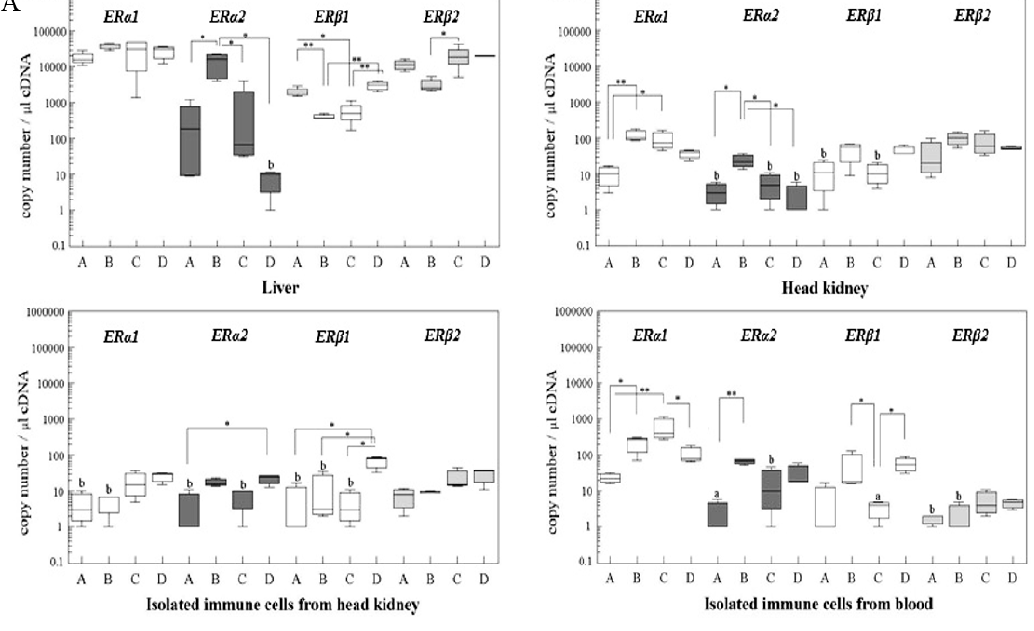
Figure 5. ( A ): The mRNA expression levels of the four ER isoforms in the liver, head kidney (HK), immune cells isolated from head kidney or from blood during the reproductive cycle. The reproductive cycle was subdivided into four stages: stage A = start of reproductive cycle, stage B = vitellogenic stage, stage C = spawning stage, stage D = post-spawning stage (see Figure 4). The gene copy number of each isoform gene per 1 µL cDNA is presented by Box-Whisker plots (group A: n = 4, B: n = 5, C: n = 3, D: n = 4). Note logarithmic scale of y-axis. * p < 0.05, ** p < 0.01. ( B ): The mRNA expression levels of the four ER isoforms in the ovaries during the reproductive cycle.